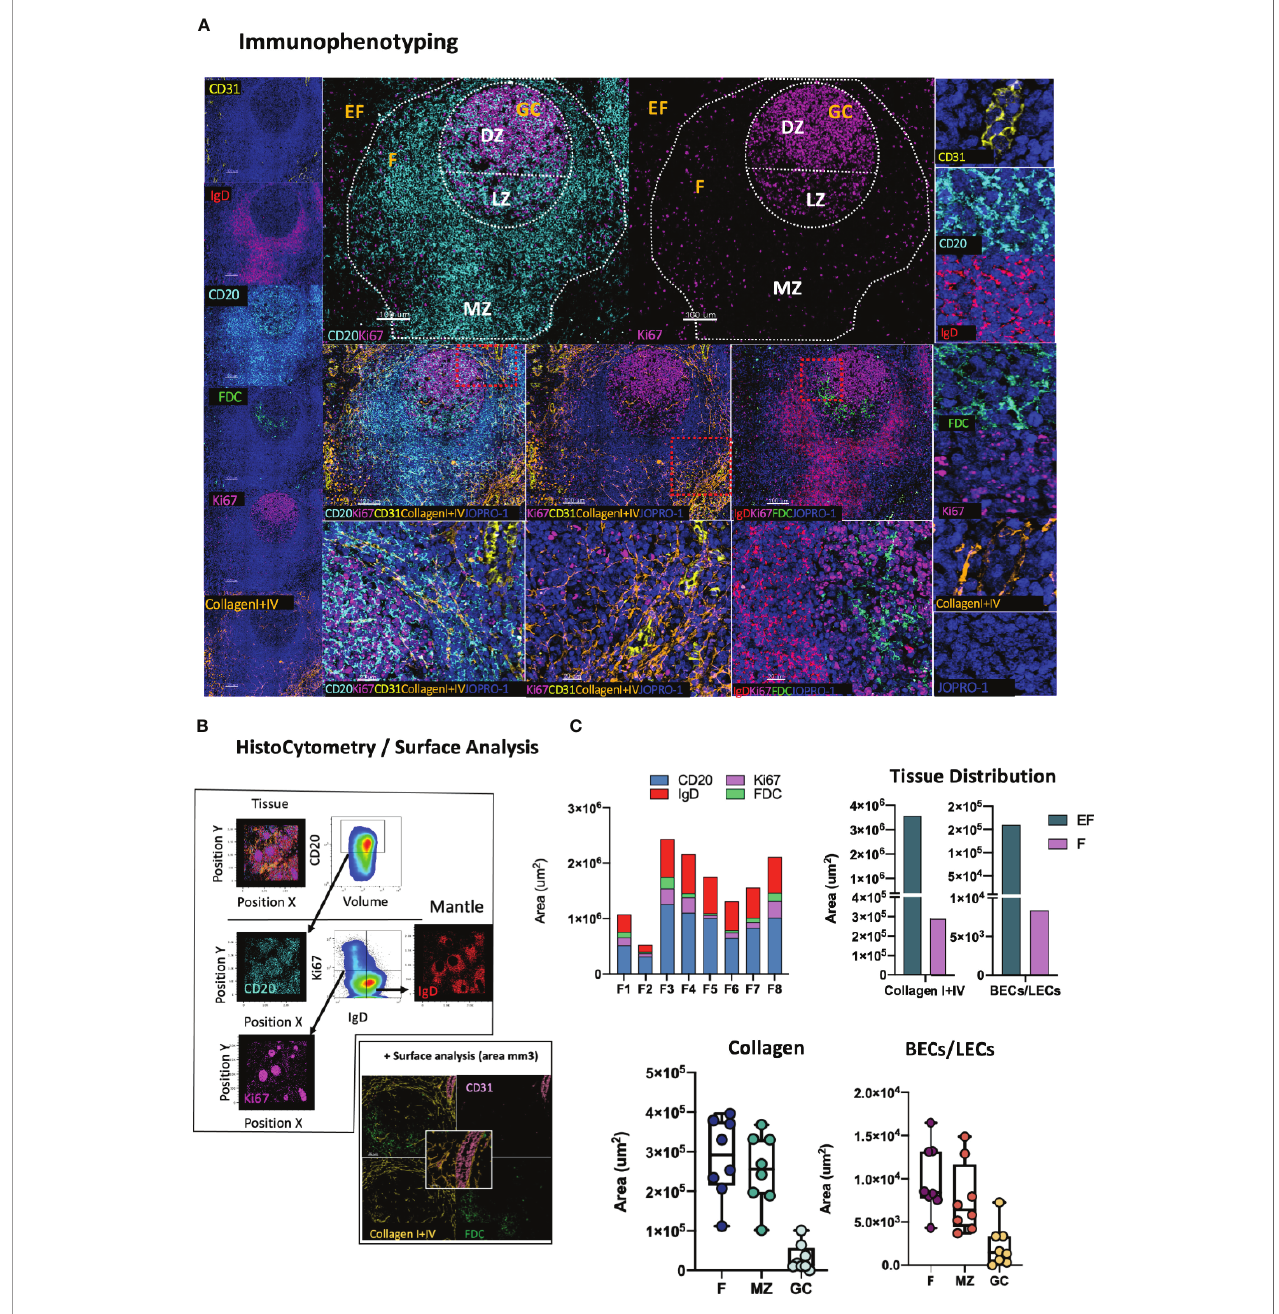
FIGURE 6 | Development of a multispectral panel for the evaluation of GC microarchitecture. (A) Representative images showing staining for CD31 (yellow), IgD (red), CD20 (cyan), FDC (green), KI67 (magenta) and Collagen I+IV (orange) in a tonsillar tissue section and individual protein marker distributions with respect to the MZ, LZ and DZ of a B-cell follicle (middle panels). Red dotted square enclosures in lower middle panels denote the areas that are presented magni fi ed in the lower middle panels. (B) Gating strategy used for the sequential positional immunophenotyping of naïve B-cells (IgD hi ) in F (CD20 hi/dim ) areas using histocytometry. (C) Box plots showing the areas (um3) occupied by each individual microarchitectural component namely B-cell follicle; CD20 hi/dim; mantle zone: IgD hi , GC (CD20 dim Ki67 hi ) and FDC network (FDC hi ) in eight distinct B cell follicles as measured by surface analysis in the program Imaris as well as the relative areas occupied by Collagen (Collagen I+IVhi) and vascular and lymphatic endothelium (CD31 hi CollagenI+IV hi ) in EF areas, F areas and GCs. Images were acquired at 40x (NA 1.3) with 1% magni fi cation. Scale bars are 100um for all panels displaying an entire follicle), 20um in the middle panel close ups and 5um in the right panel single staining close ups. BEC, Blood Endothelial Cell; LEC, Lymphatic Endothelial